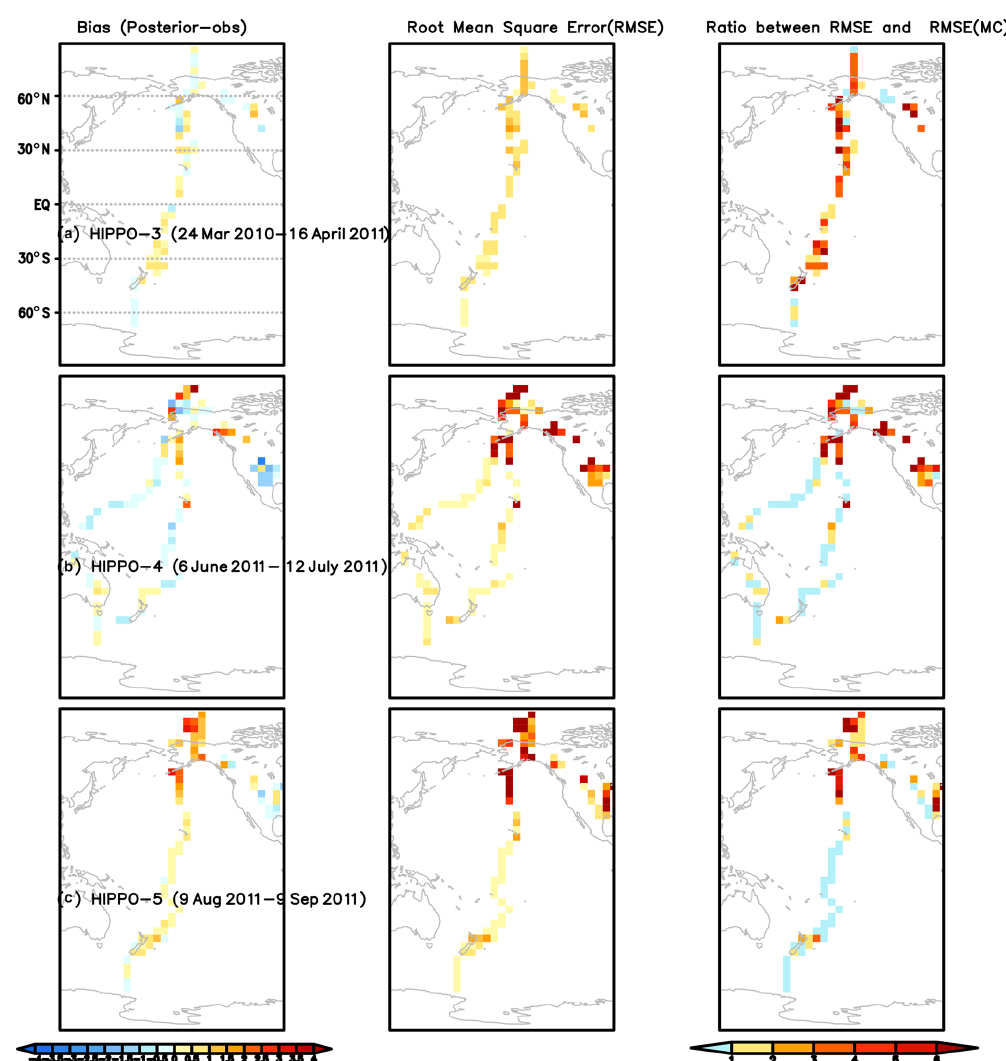
Figure 11. Left column: the mean differences between posterior CO 2 and aircraft observations from HIPPO 3–5 aircraft campaigns between 1–5km (a–c) (unit: ppm). The time frame of each campaign is in the figure. Middle column: the root mean square errors (RMSEs) between aircraft observations and posterior CO 2 between 1–5km (unit: ppm). The color bar is the same as in the left column. Right column: the ratio between RMSE and RMSE MC based on ensemble CO 2 from the Monte Carlo